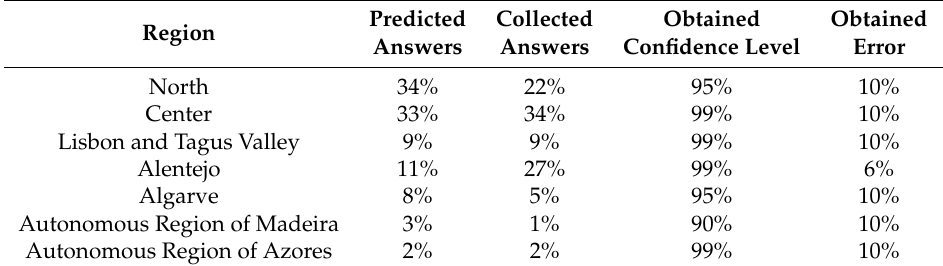
Table 3. Percentages by Region of collected